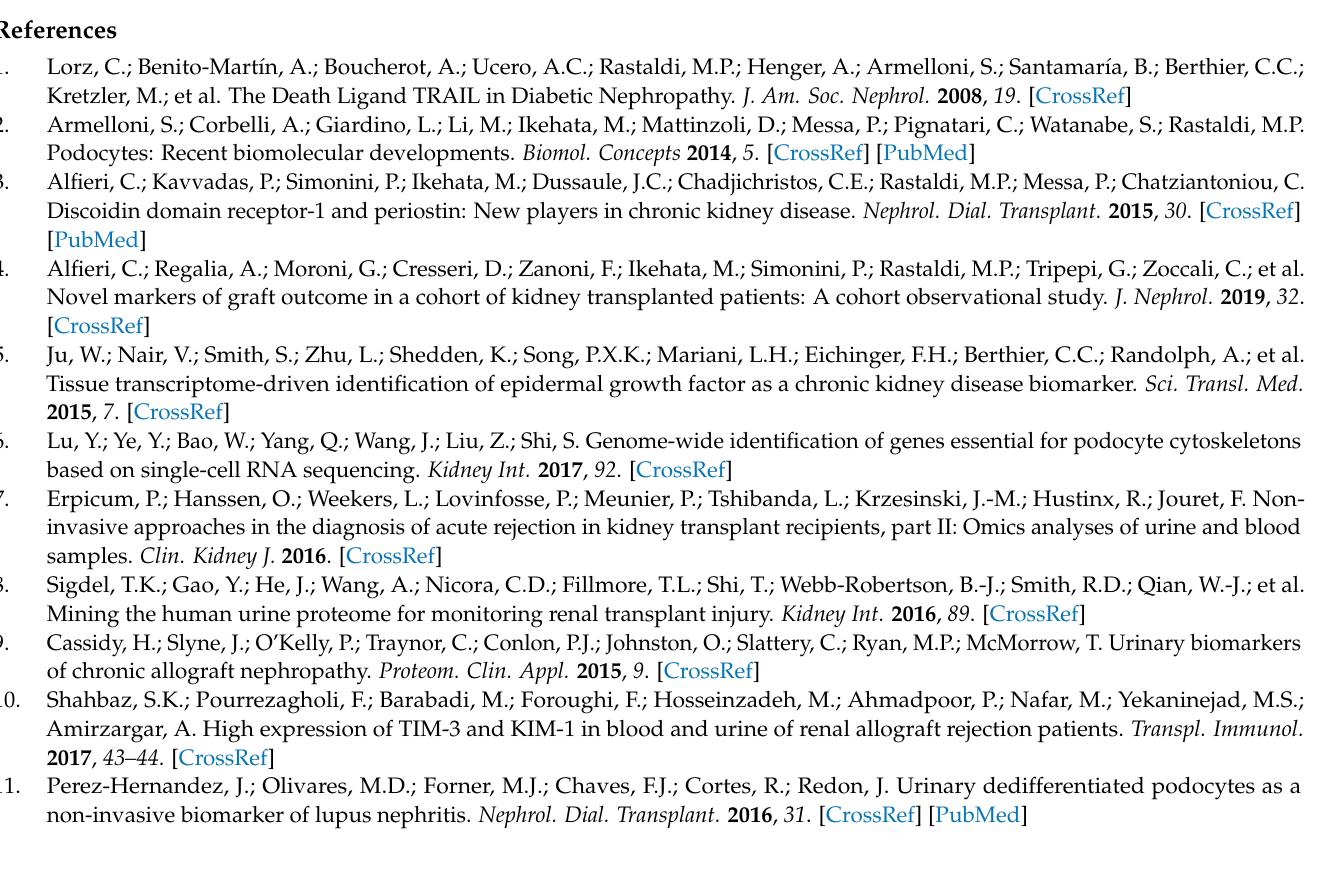
podocytes characterization, Table S1. Primer sequences, Table S2. Correlation among gene